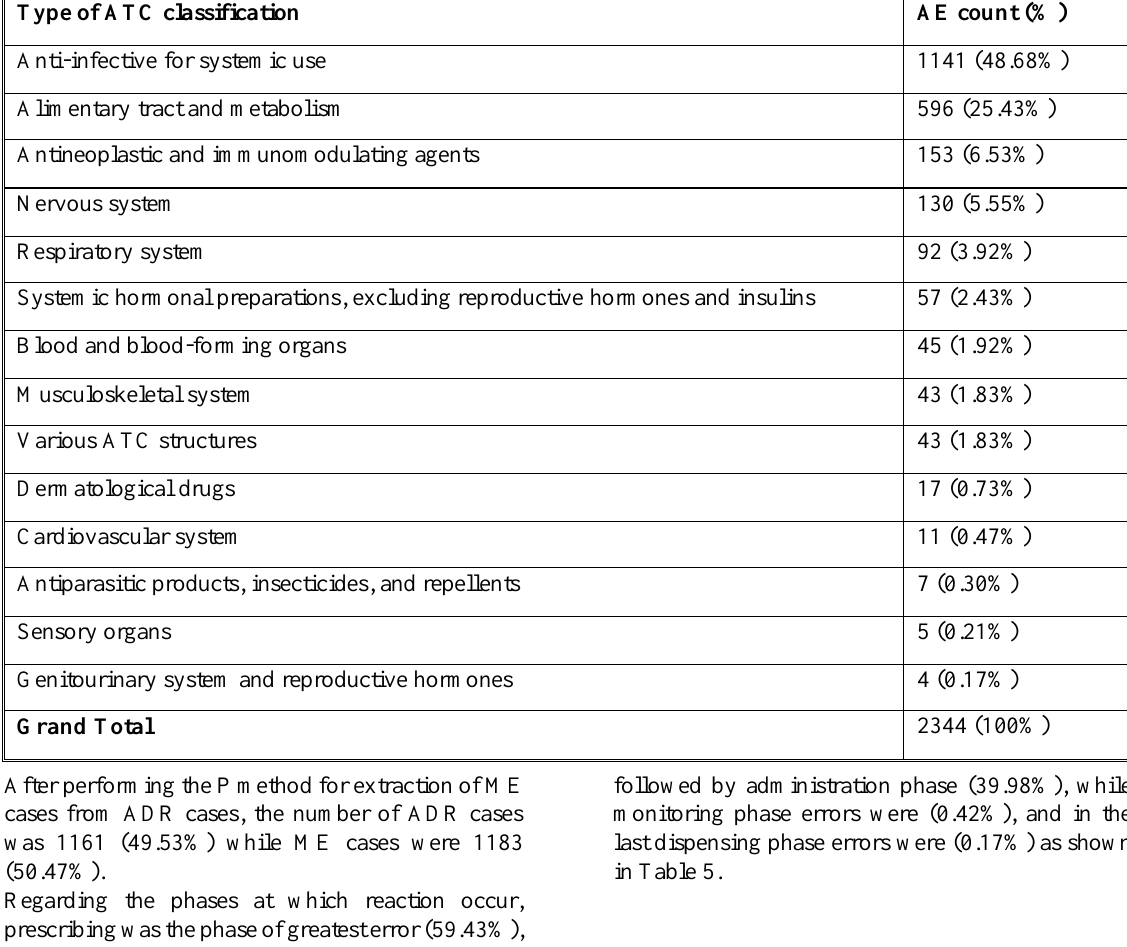
Table 4. Classification of drugs involved in the individual case safety reports.